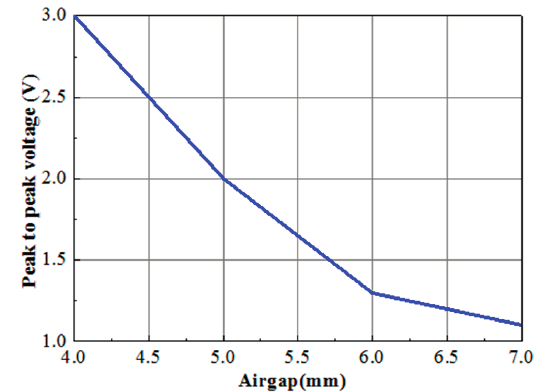
Figure 7. Peak to peak value of the sensor output signal with the variation of airgap.